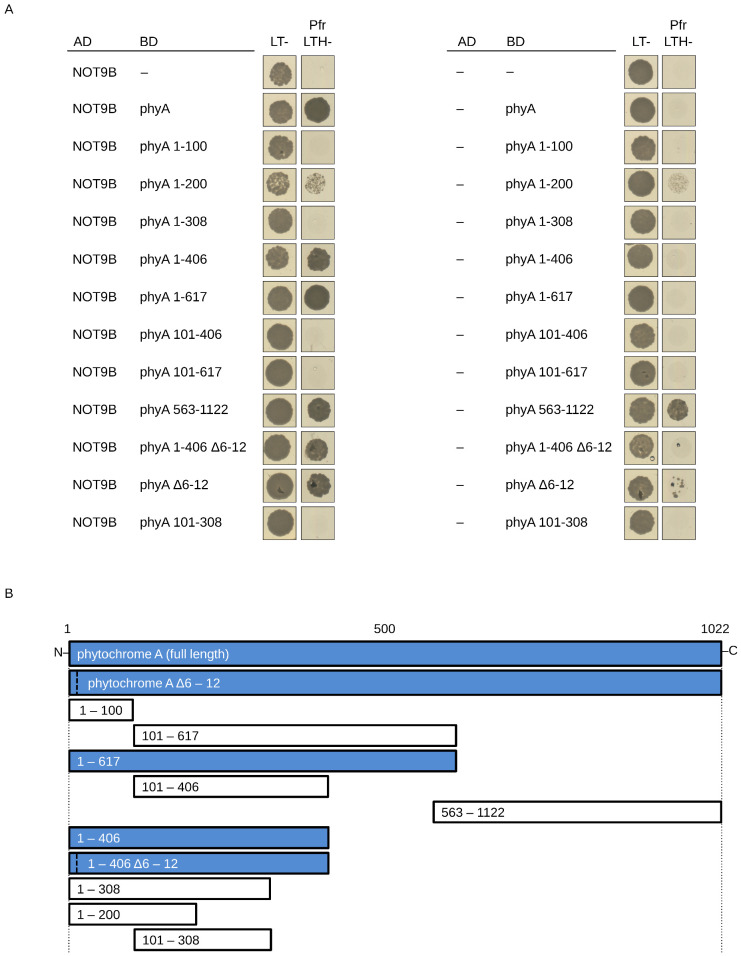
NOT9B binds to the N-terminal half of phyA.(A) Y2H growth assay. AH109 yeast cells were transformed with plasmids coding for the indicated AD and BD fusion proteins and grown in R light (Pfr) on CSM LTH- plates supplemented with 10 mM 3-AT and 20 μM phycocyanobilin. CSM LT- plates were used as transformation control. (B) Schematic overview on phyA fragments used in (A). Interacting fragments are highlighted in blue.